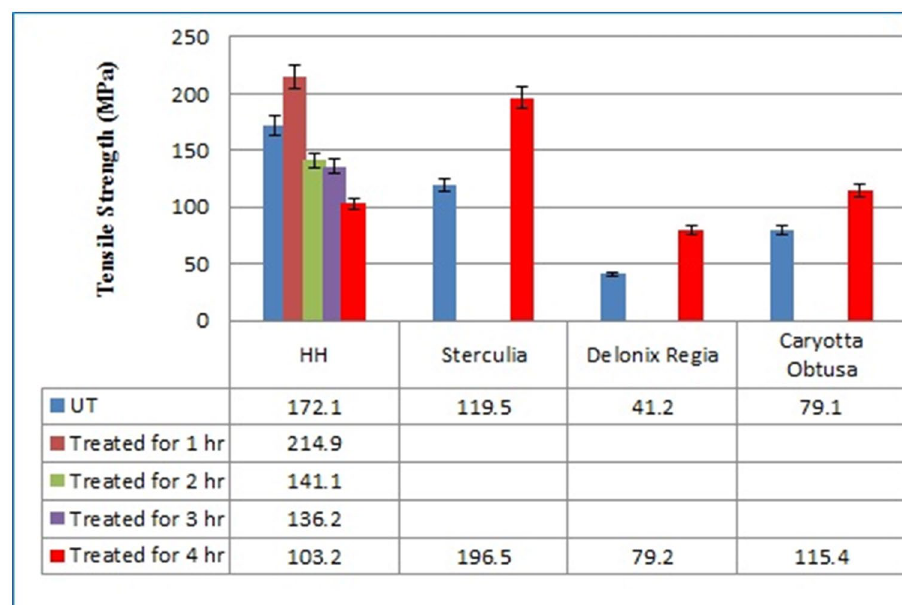
Fig. 8 Tensile strength of untreated and treated natural